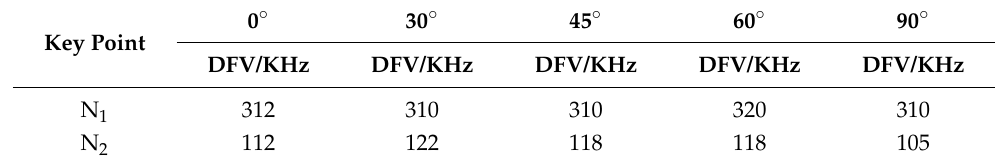
Table 4. Dominant frequency value of key point for different bedding angles under natural state.